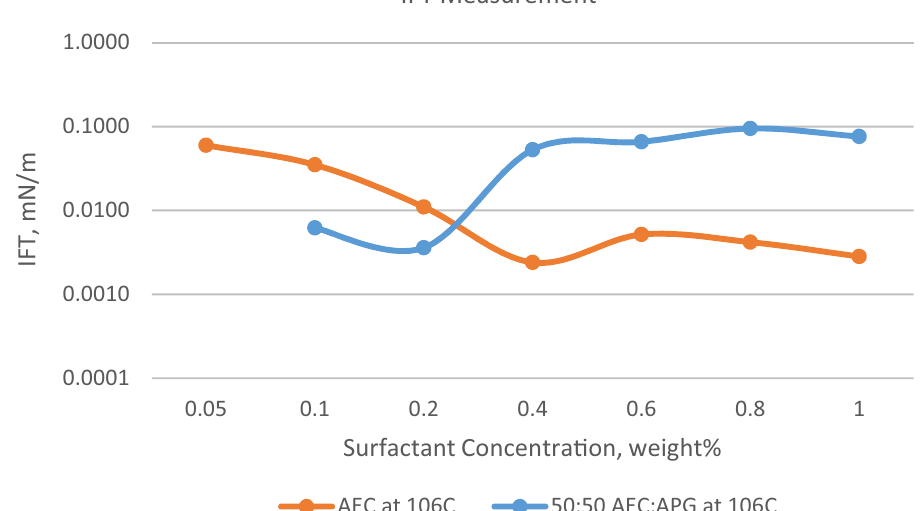
Fig. 13 Interfacial tension, mN/m of AEC and AEC/APG surfactant at different concen- trations at 106 °C in seawater salinity brine